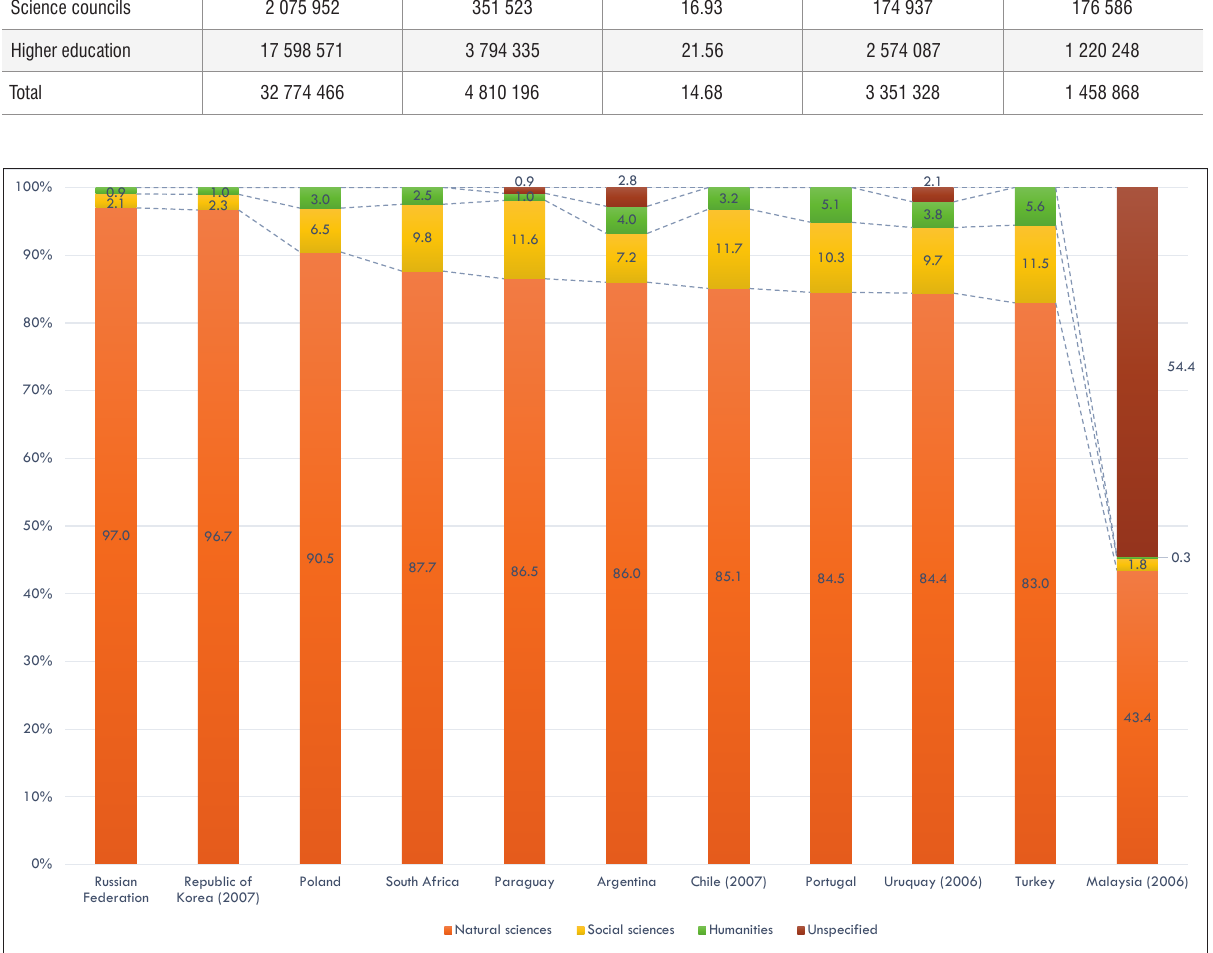
Figure 1: International comparison of R&D expenditure by research field as a % of GERD,